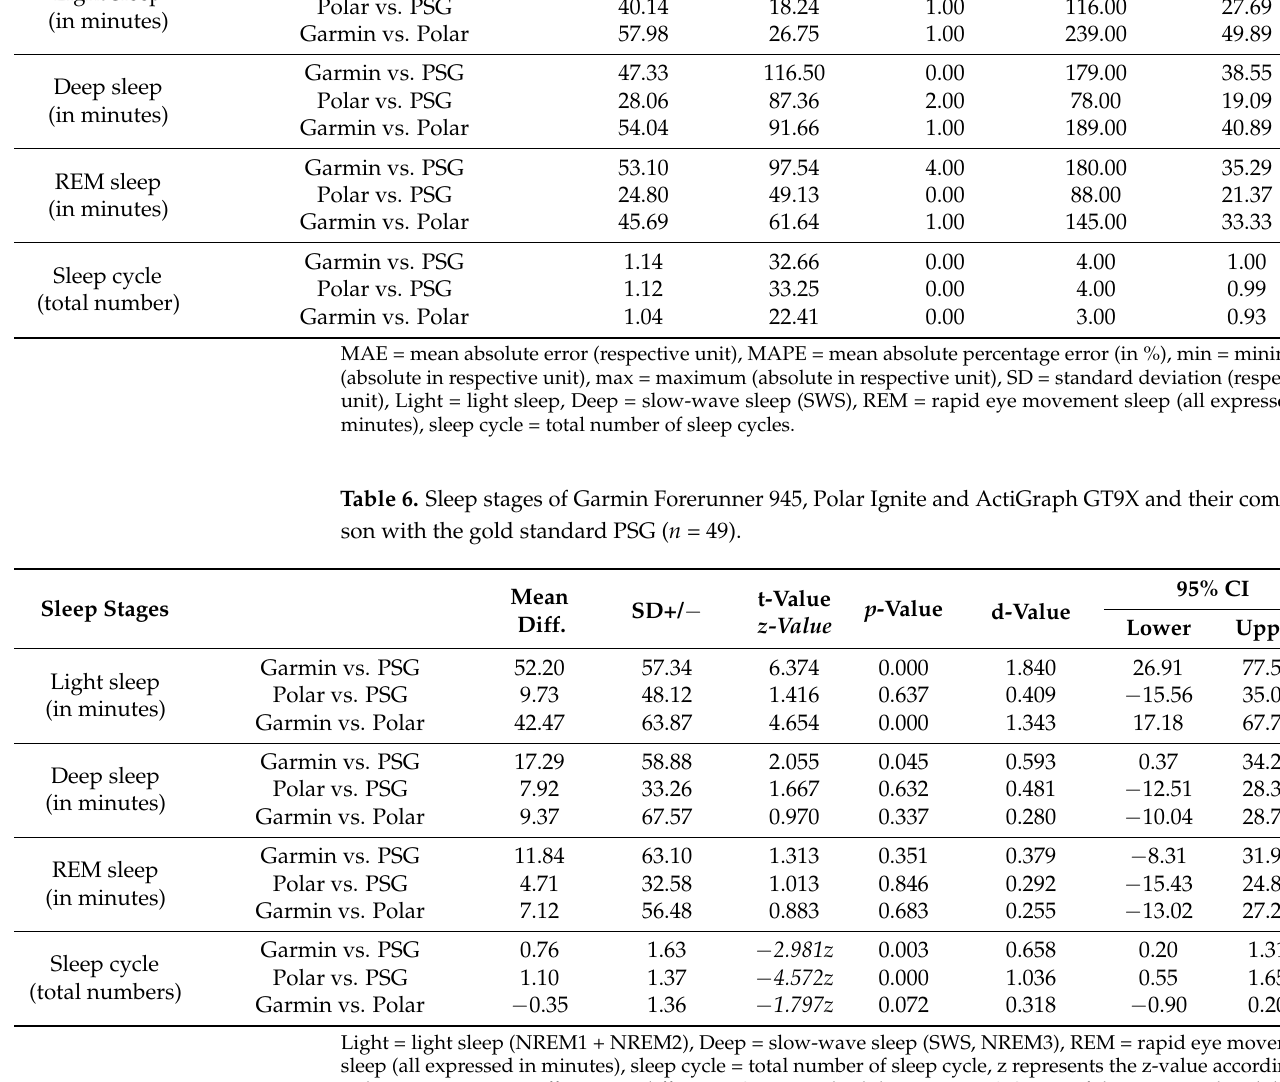
The Bland–Altman diagrams and the boxplot analysis show differences between the two activity trackers Garmin and Polar, as well as the larger differences measured in light and deep sleep with Garmin (Figures 3 and